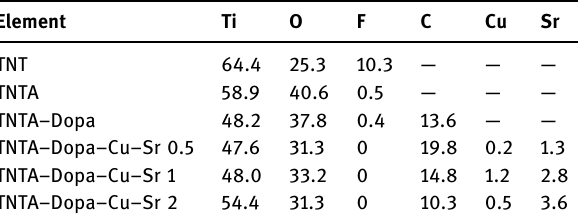
Table 1: The element concentrations ( wt% ) of the di ff erent samples characterized by EDS